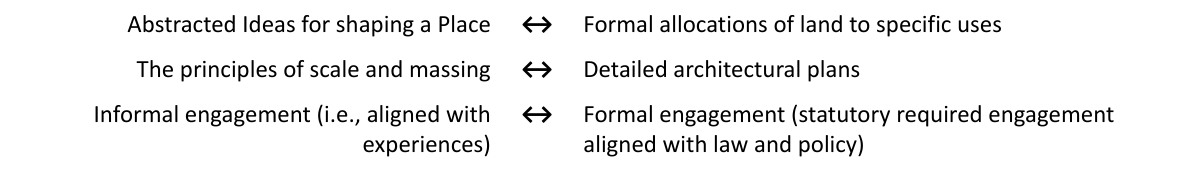
Figure 3. Levels of abstraction and engagement